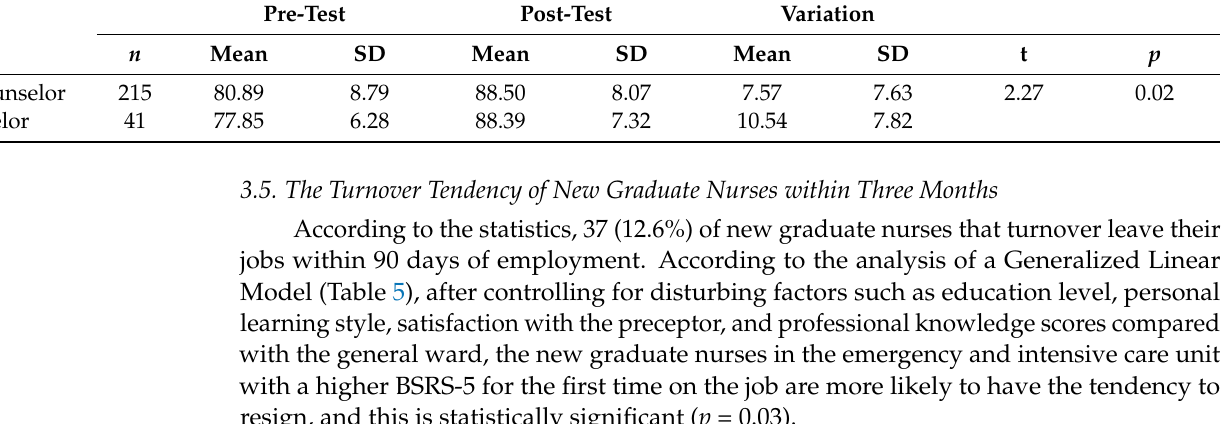
Table 4. Variate analysis of the professional knowledge scores for NGNs receiving gentle care and counseling. Pre-Test